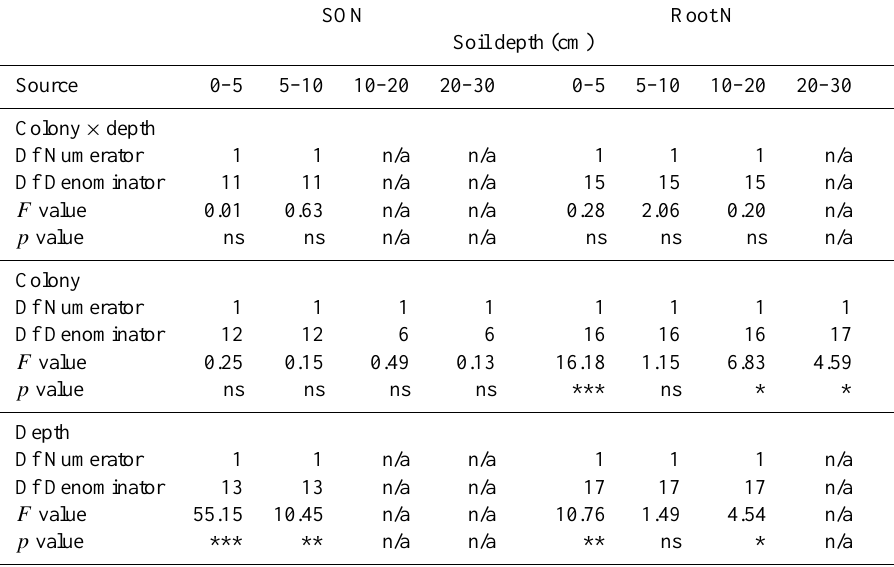
Table 2. Results of two-way ANOVA of the depth distribution of SON and Root N per soil depth, using colony and tephra depth as fixed. Significant source variables ( p <0.05) with respect to soil depth are indicated with an asterisk: ns is p >0.05, * p is 0.05–0.01, ** p is 0.01–0.001, *** p